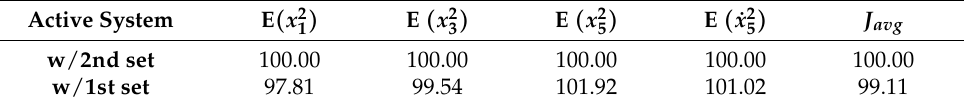
Table 2. Components of performance indices obtained by active suspension system after running on asphalt road.